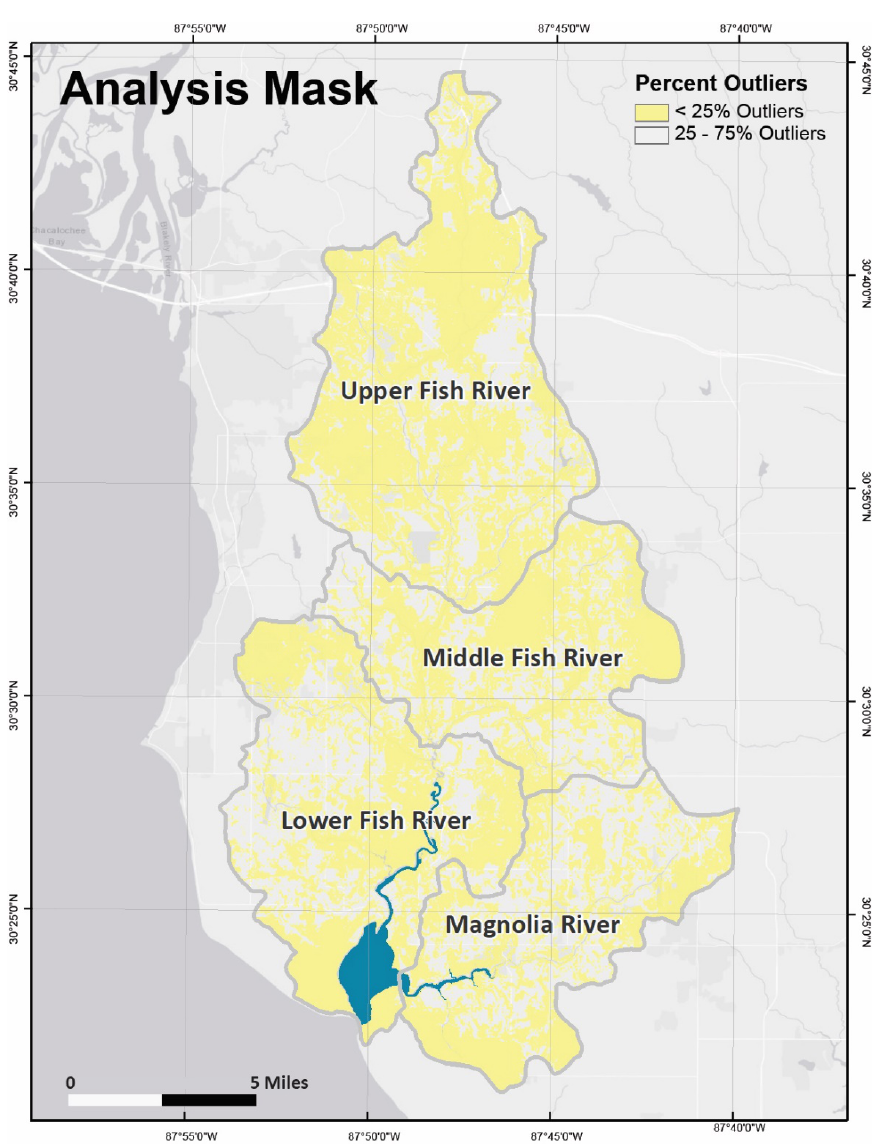
Figure 4. The area highlighted in yellow represents where the AHP model agreed based on one- percent changes to criteria weights with minimal outliers.